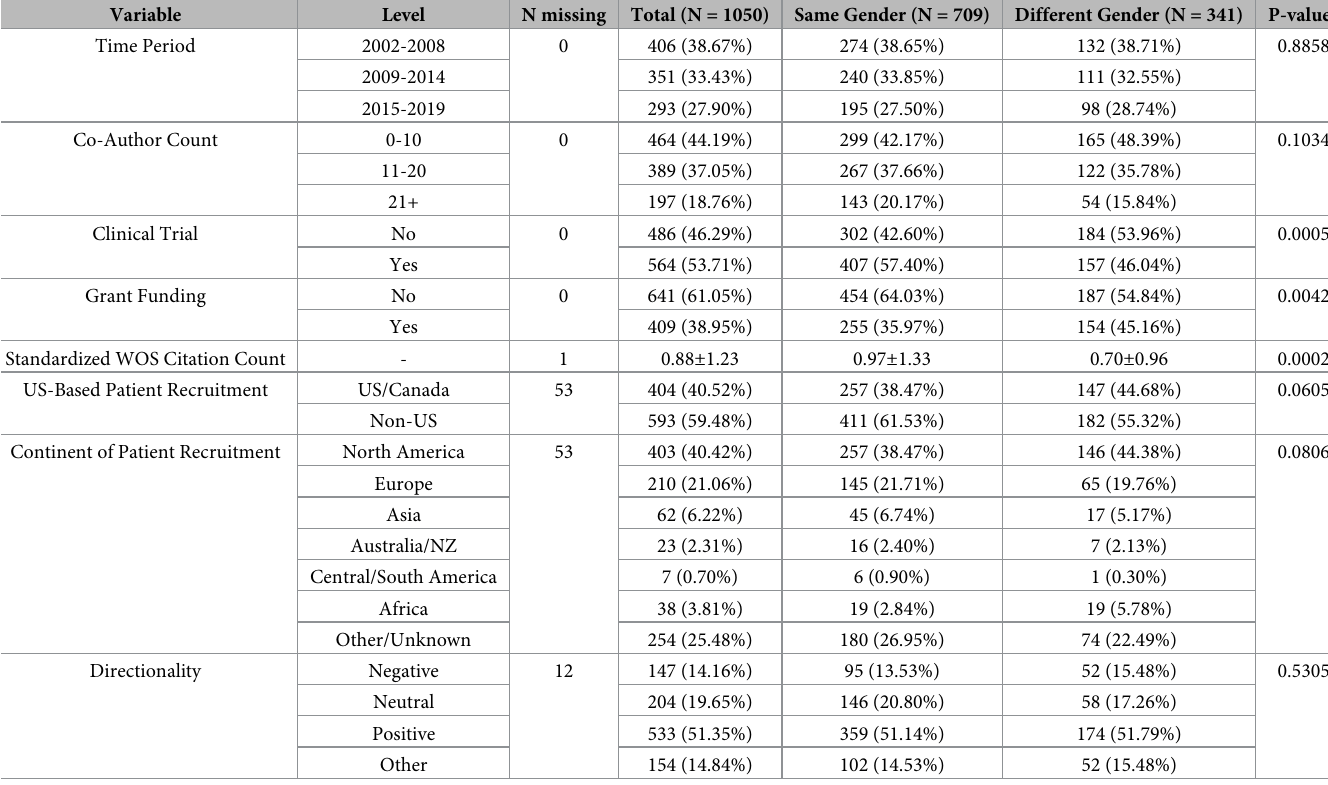
Table 11. Publication characteristics for first/last author same gender teams (2002 – 2019).